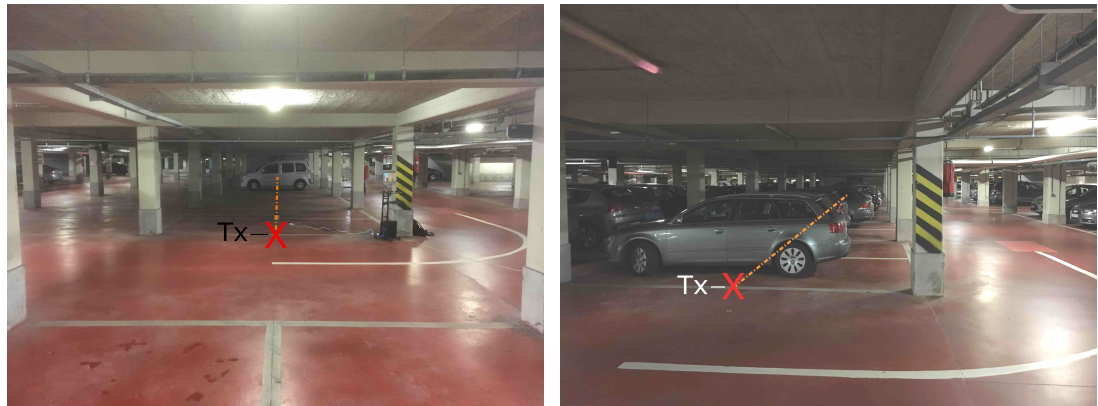
Figure 3. Scenario OW: View from behind the Tx (red X), for the nearly empty underground parking garage ( left ); and the view to the side of the Tx (red X), at the moment when the garage was nearly full ( right ). The measurement path is indicated by the dashed orange